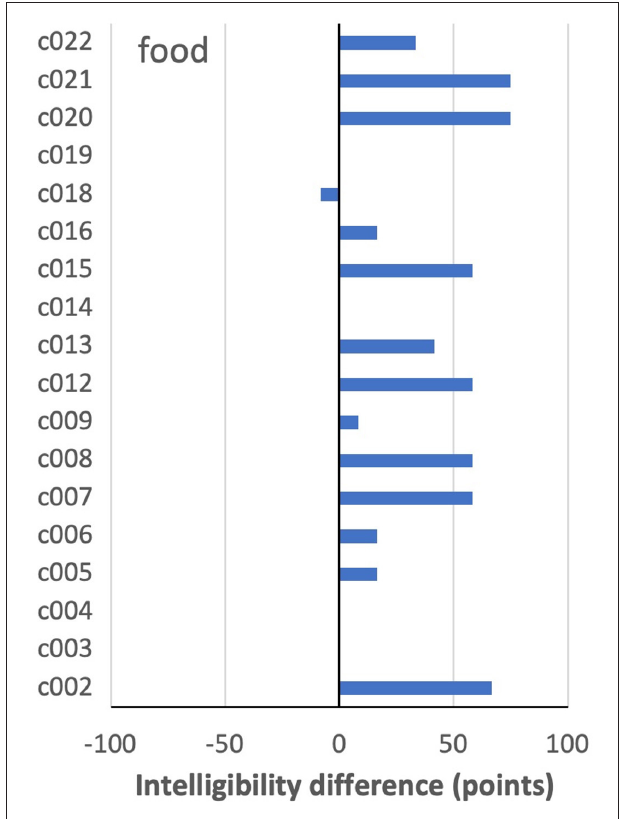
FIGURE 3 | By-speaker differences between mean intelligibility scores on the two tasks for food